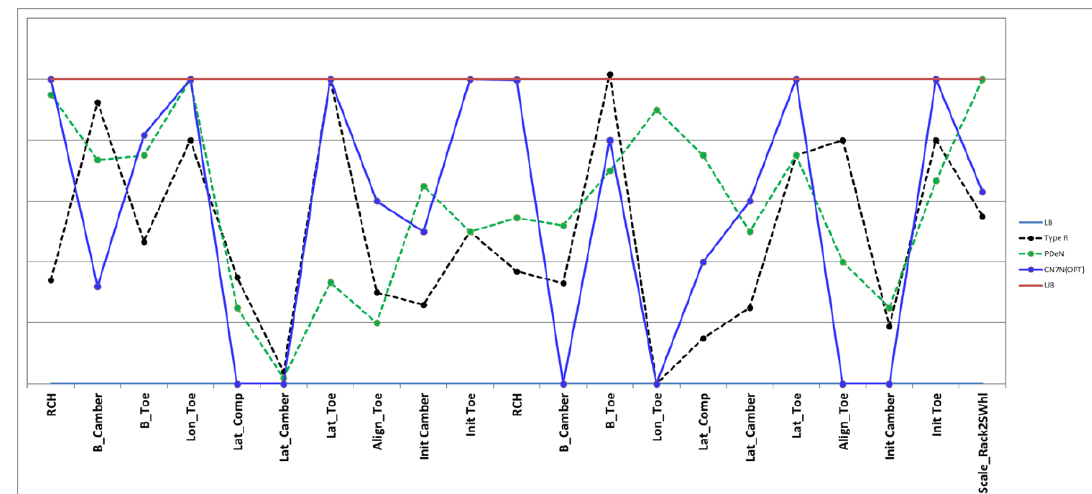
Figure 10. Optimizing within the K&C design guide.